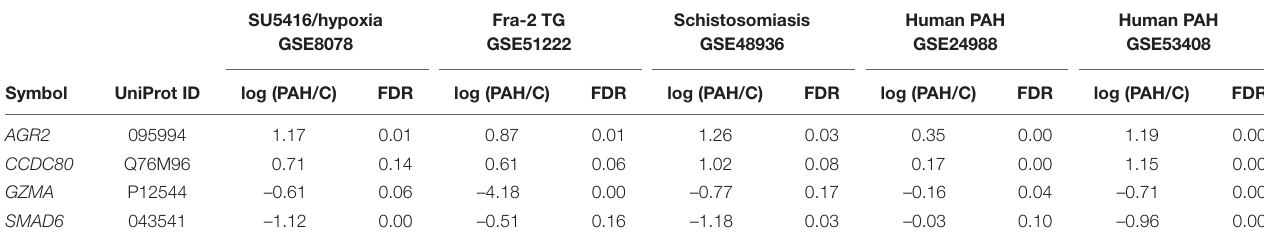
TABLE 1 | Differentially expressed genes common to the five PAH transcriptome